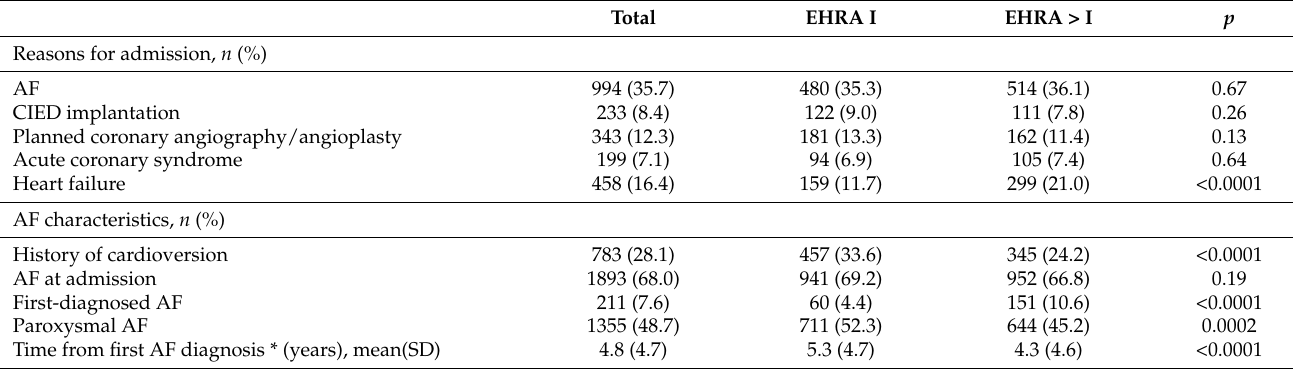
Table 1. Reasons for hospital admission and AF